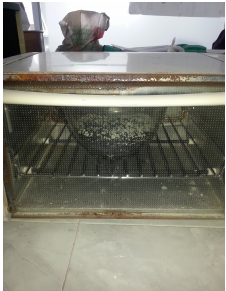
Figure A10. Combined (natural and synthetic)